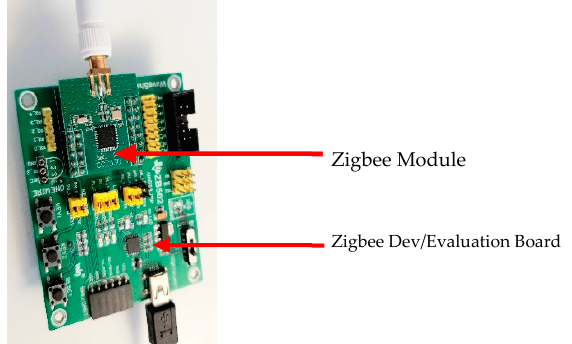
Figure 7. A CC2530 Zigbee module and ZB502 development board used to configure the Zigbee network during the research [75].